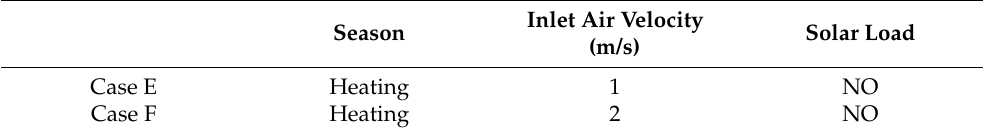
Table 2. Summary of the studied configurations in winter–eating conditions.